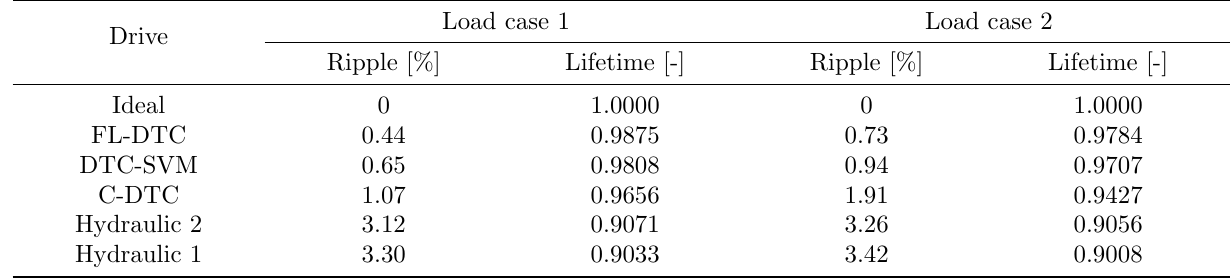
Table 11: Ripple percentage and influence on gearbox lifetime of the simulated drive variants